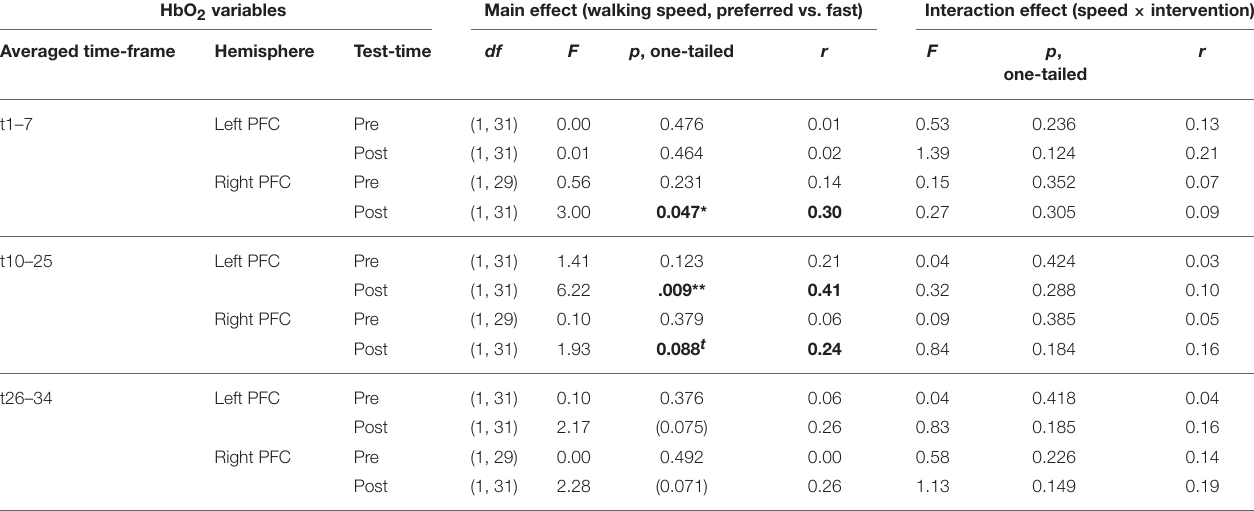
TABLE 4 | Results of repeated measures ANOVA for preferred vs. fast walking speed PFC activity. HbO 2 variables Main effect (walking speed, preferred vs.